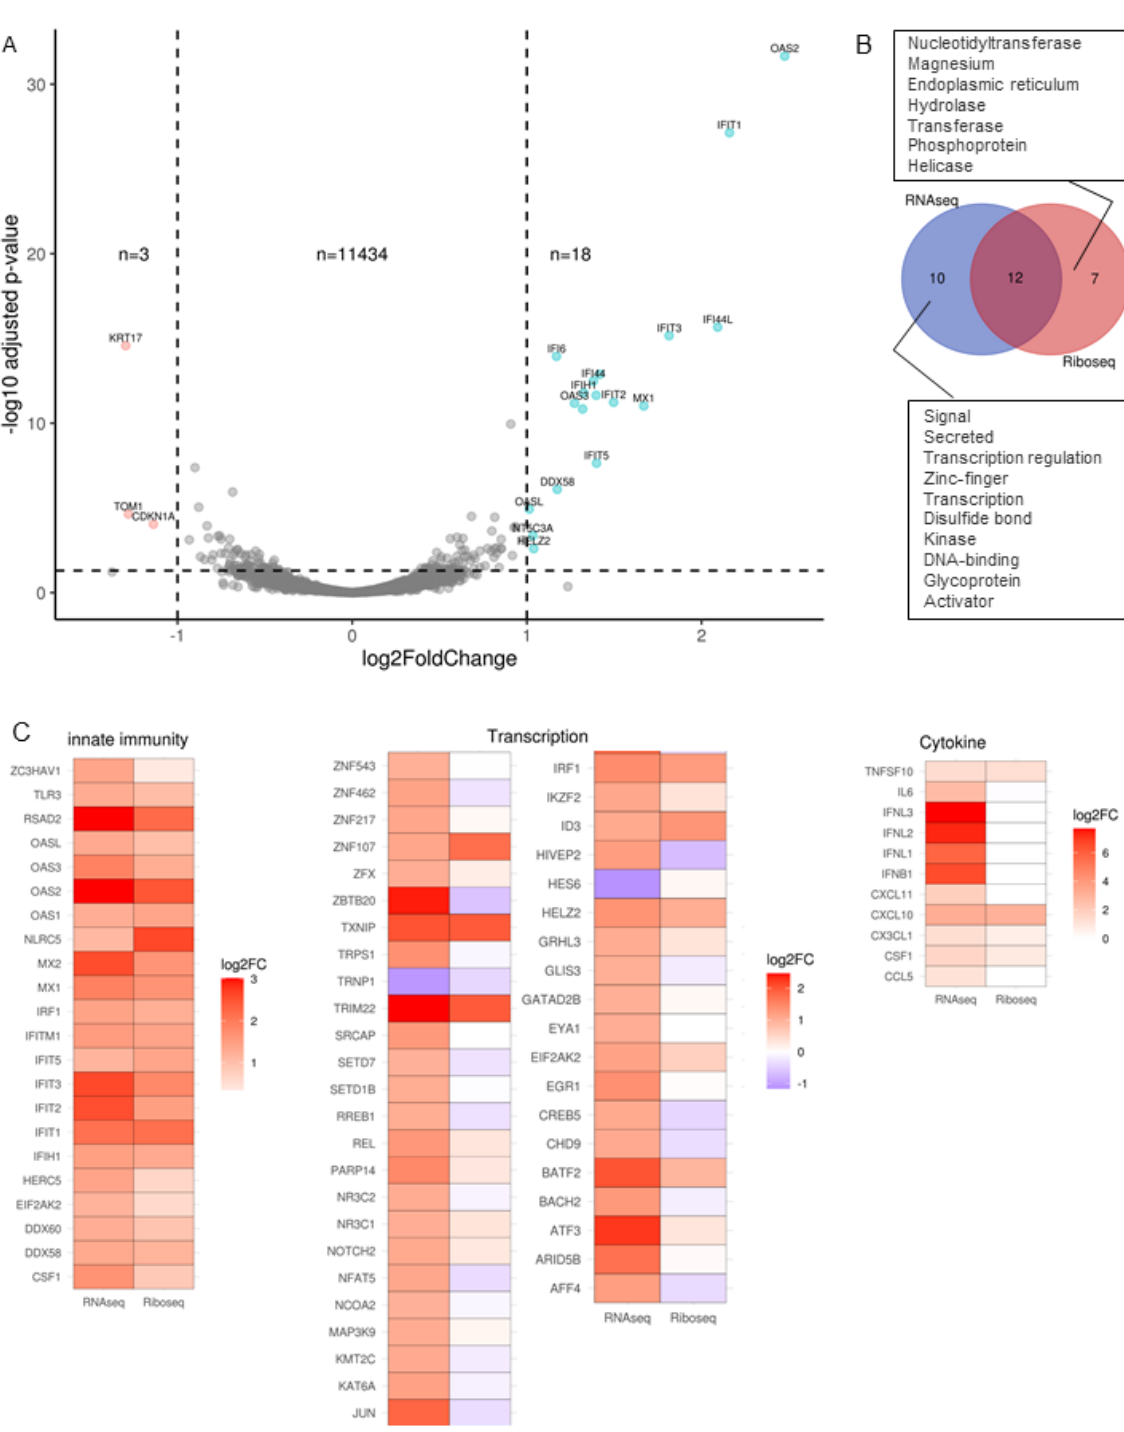
Figure 4. Absence of transcription factors and cytokines from genes up-regulated by ribosome foot-printing. ( A ) Volcano plot showing global translational changes of ~11,000 genes in SARS-CoV-2 infected Calu-3 cells. Log2FoldChange infected 24 h versus mock. 21 genes were differentially expressed (DE) in SARS-CoV-2 infected cells based on the cut-off of p -value < 0.05, log2fold change > 1. ( B ) Functional annotation clustering on the differential expression gene lists for RNA-seq versus Ribo-seq. Uniprot keywords used to classify genes showed an absence of keywords ‘Signal’, ‘Secreted’ and ‘Transcription regulation’ in the Ribo-seq gene list. ( C ) Heat-map of the log2 fold change of up-regulated RNA-seq transcripts included within ‘Innate immunity’, ‘Transcription’ and ‘Cytokine keywords’ alongside their log2 fold change as determined by Ribo-seq.